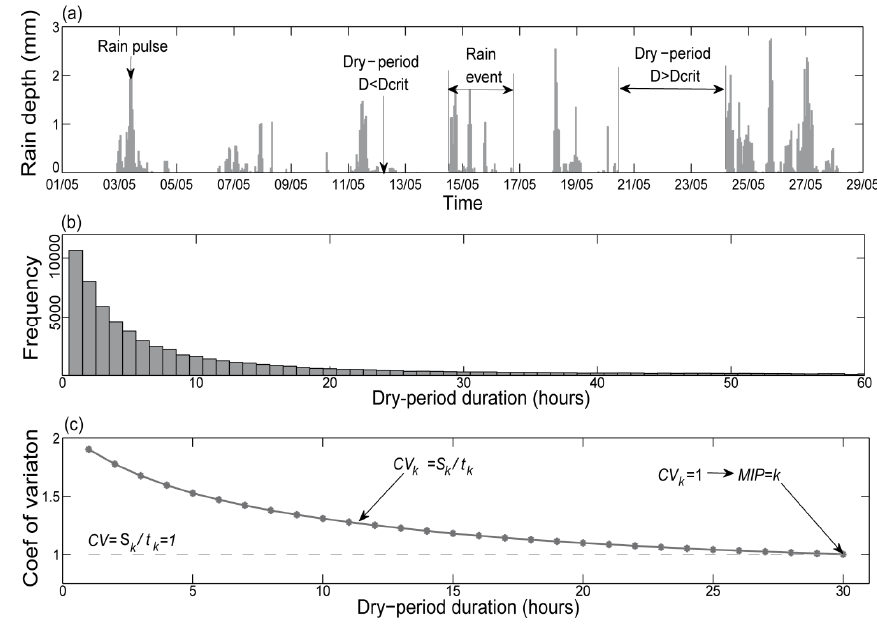
Figure 3. ( a ) Rainfall intensity series where dry periods are identified; ( b ) dry-period duration histogram; and ( c ) intersection of the curve of CV k with the line CV “ 1 that indicates the minimum inter-event period that ensures storm event independence.